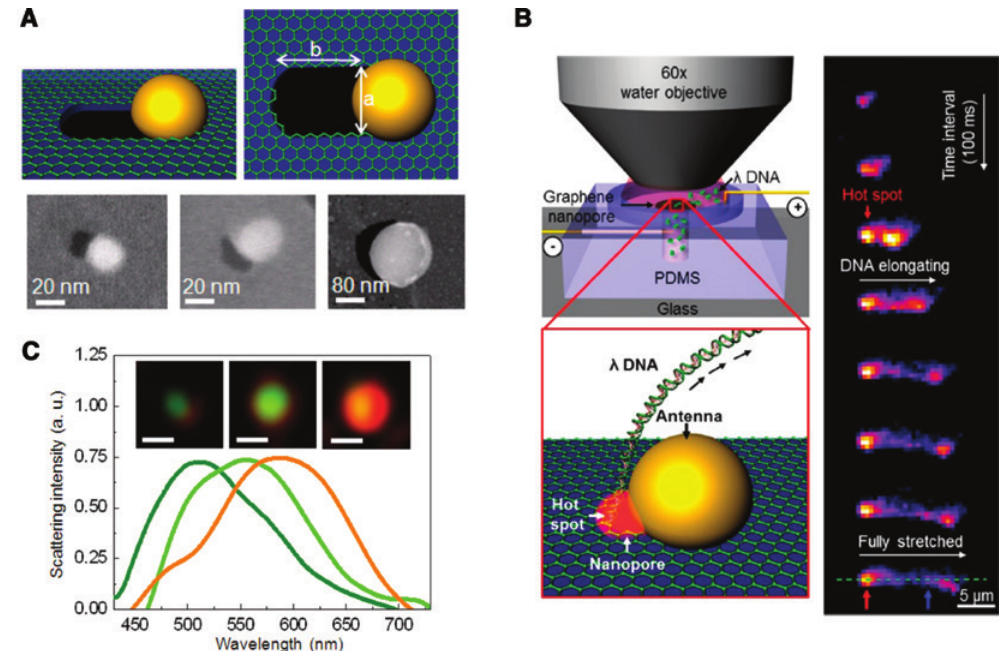
Figure 4: Graphene nanopore with a self-integrated optical antenna. (A) Illustrations and SEM images of graphene nanopores and differently sized, integrated Au nanoparticles: 10 nm × 38 nm and 25 nm × 73 nm (short by long axis lengths) gold nanorods as well as 150-nm diameter gold nanospheres. (B) Darkfield scattering images and the corresponding spectra of plasmonic nanoparticles taken from nanopores with the self-integrated nanoantennae above, with a scale bar = 0.5 μ m. (C) DNA translocation through integrated graphene nanopores with an optical antenna. The left inset depicts the device with its array of graphene nanopores and integrated nanoantennae. The right inset shows a zoomed-in view of plasmonically enhanced fluores- cence of stained λ DNA when passing through the hot spot/opening. More specifically, it is a time series of confocal scanning fluorescence images of λ DNA translocation with a time interval of 100 ms. Adapted from